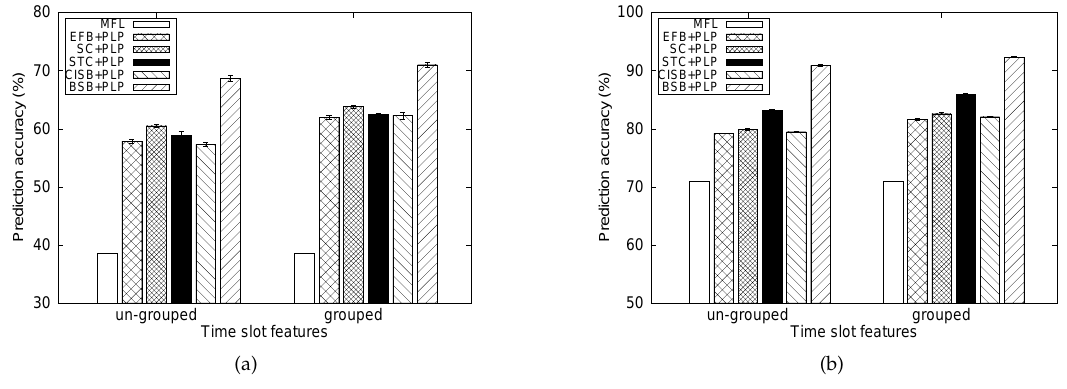
Figure 8. Comparison of time slot features in the human prediction framework in case of ( a ) the MIT dataset and ( b ) Dartmouth